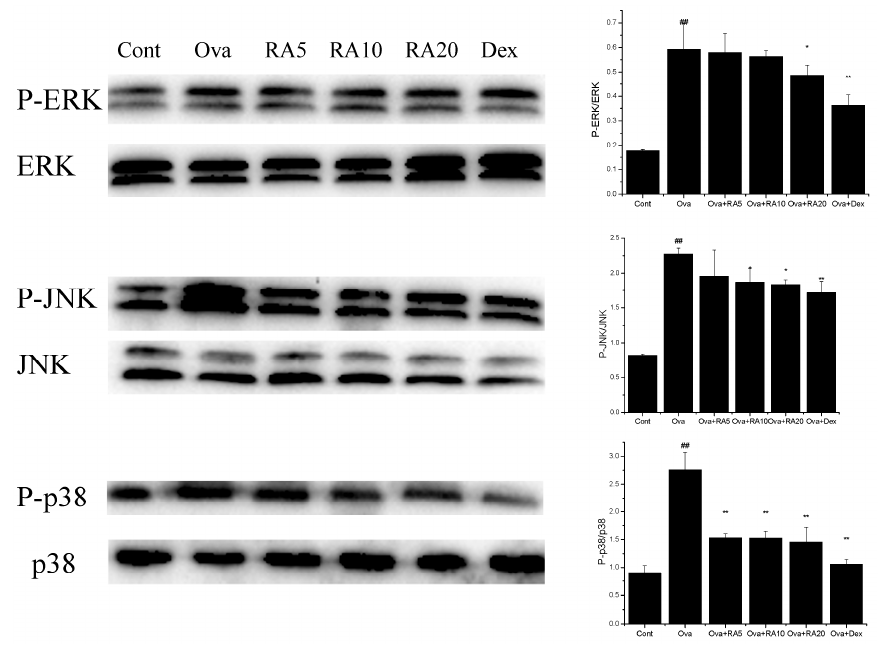
Figure 5. Effects of RA on the Ova-induced phosphorylation of MAPK molecules in the lungs. Cellular proteins isolated from mouse lungs were used for detection of the phosphorylated and total forms of three MAPK molecules, ERK, JNK and p38, via Western blotting. The values represent the mean ± SEM of three independent experiments. # p < 0.05, ## p < 0.01 vs. control group; and * p < 0.05, ** p < 0.01 vs. Ova.